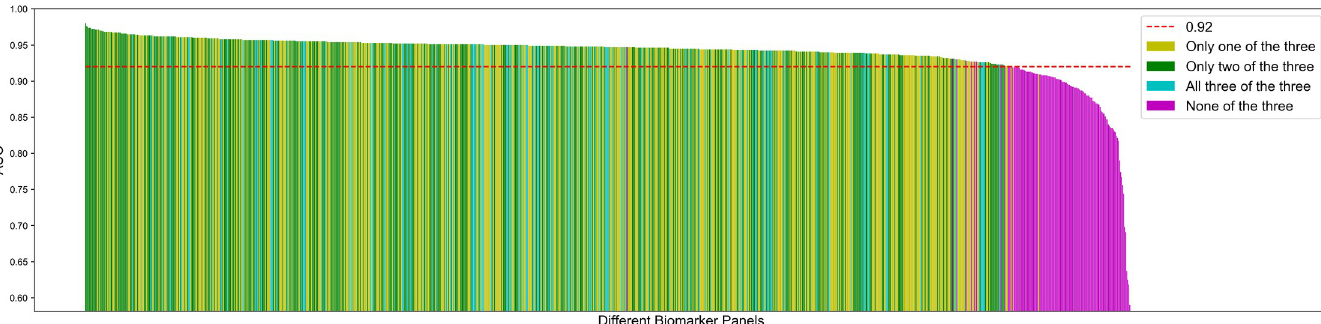
PLOS Pathogens| https://doi.org/10.1371/journal.ppat.1009773 August 17,